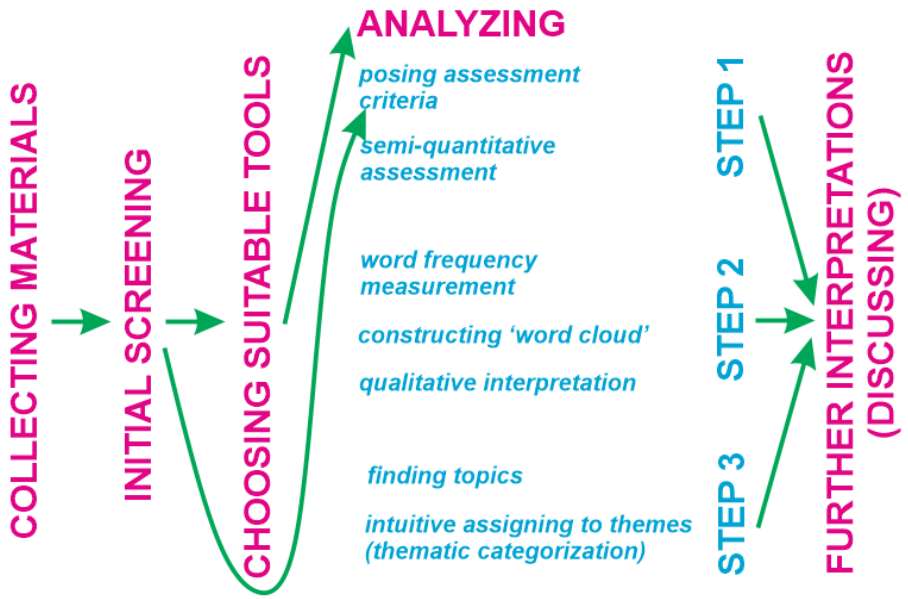
Figure 1. Methodological framework of the present study.